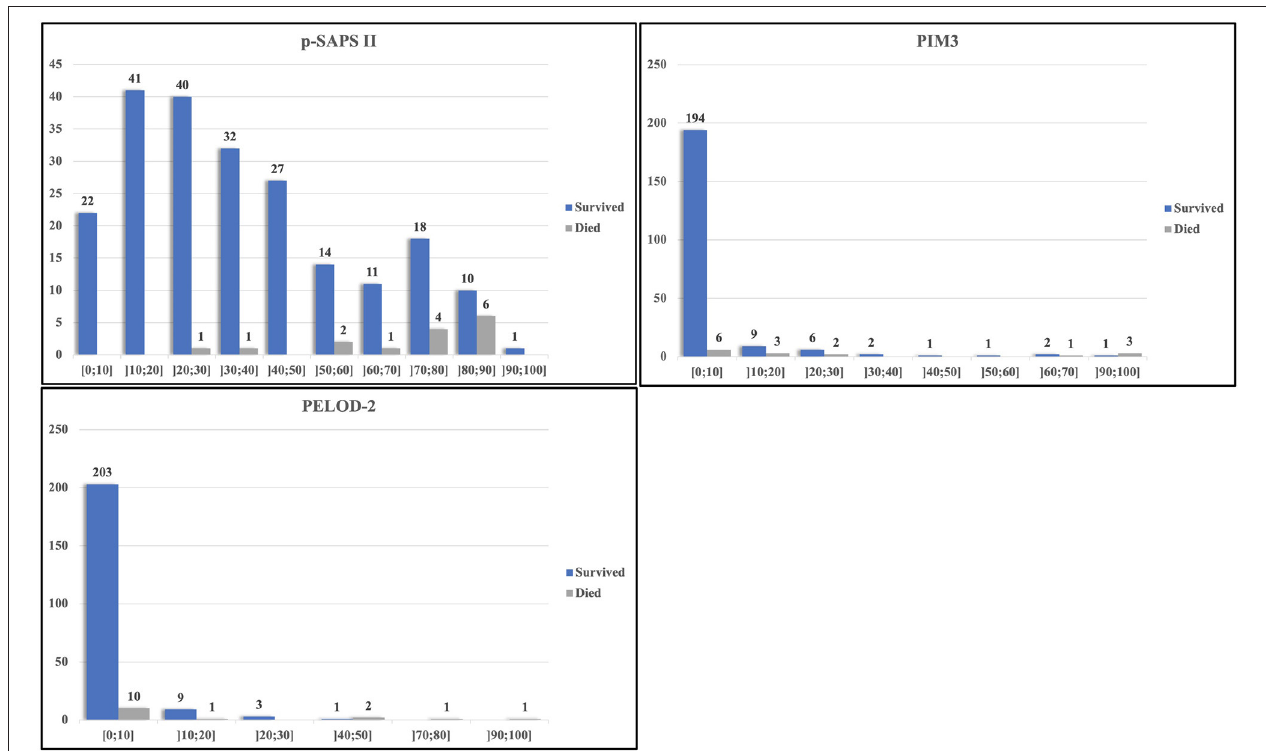
FIGURE 2 | Distribution of scoring results and observed